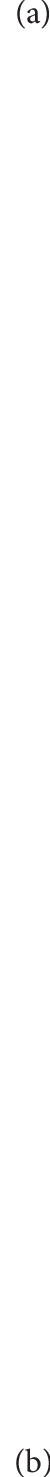
SCAP. Columnar epithelial cells with decapitation secretion line a papillated structure. A myoepithelial cell layer was present. The stroma contains numerous plasma cells 20x.